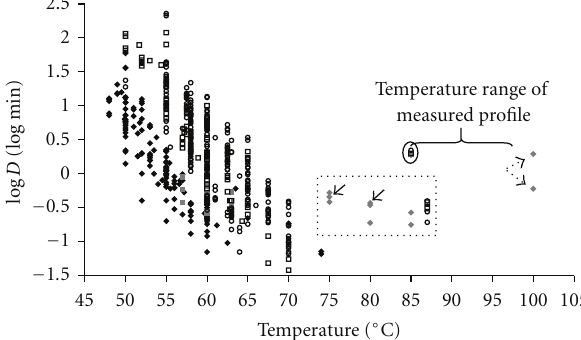
Figure 3: log D -values plotted against temperature for Campy- lobacter (black diamond), Lactobacilli (grey square), Escherichia coli (hollow square), and Salmonella (hollow circle) as reported in literature. Campylobacter data for which a decimal reduction time was plotted against heating temperature, instead of D -value against matrix temperature: grey diamond. Encircled solid line: current D boil data plotted against lowest surface temperature measured; range of the increasing temperature profile the meat was exposed to; boxed dotted line: D -values or decimal reduction times based on heating times ≤ 60s, T > 70 ◦ C. Dotted arrows indicate data from Bergsma et al. [24]; solid arrows indicate data from Purnell et al.